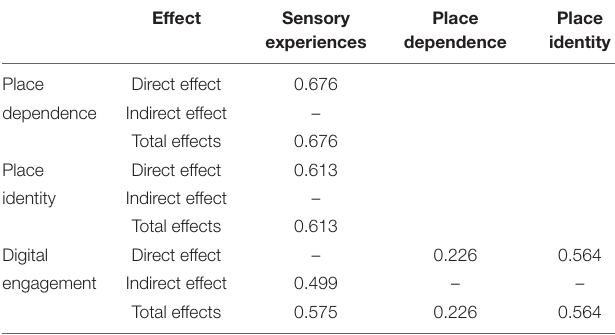
TABLE 6 | Direct effect, indirect effect, and total